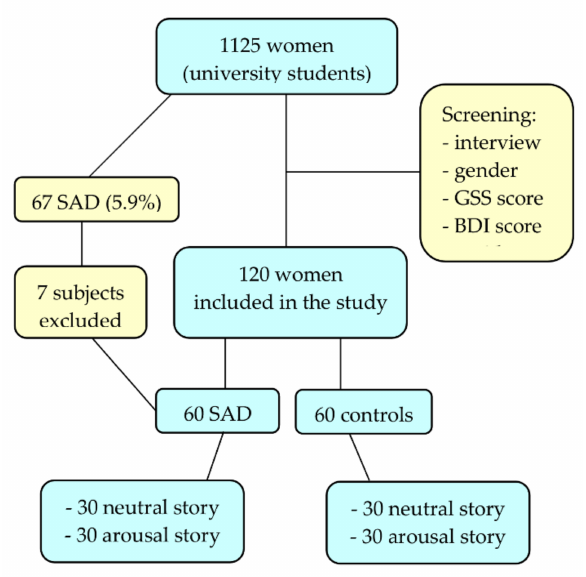
Figure 1. Sampling flow